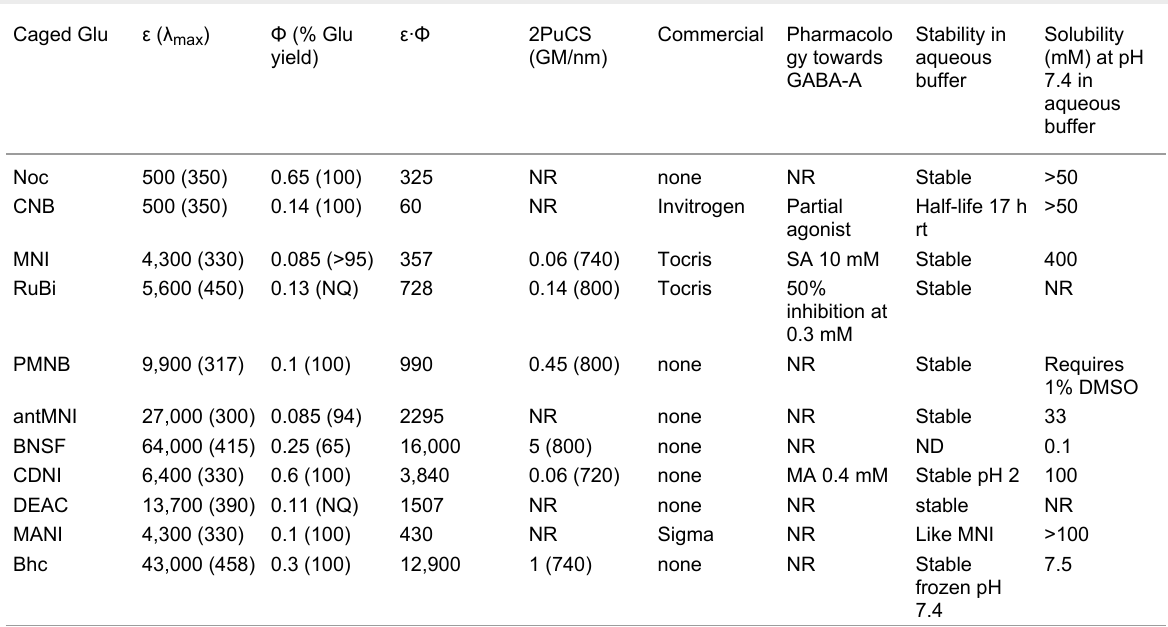
a Abbreviations and symbols: ε , extinction coefficient; Φ , quantum yield; 2PuCS, 2-photon uncaging cross section; NR, not reported; MA, mild agonist; Noc, N -nitrophenethyloxycarbonyl; CNB, carboxynitrobenzyl; MNI, methoxynitroindolinyl; RuBi, ruthenium-bipyridine; PMNB, propylmethoxynitro- biphenyl; antMNI, antennea-methoxynitroindolinyl; BNSF, bisnitropropylstyrylfluorene; CDNI, carboxymethylnitroindolinyl; DEAC, diethy- laminocoumarin; MANI, methylacetoxynitroindolinyl; Bhc,